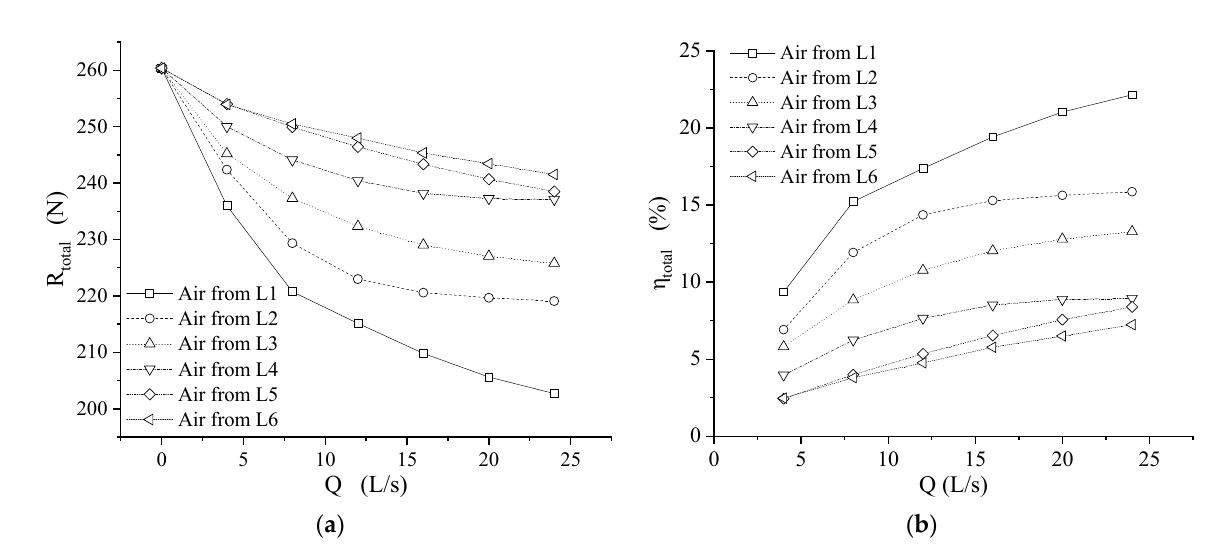
Figure 6. Resistance and drag reduction in SWATH with different air injection locations: ( a ) Total resistance; ( b ) Drag reduction.